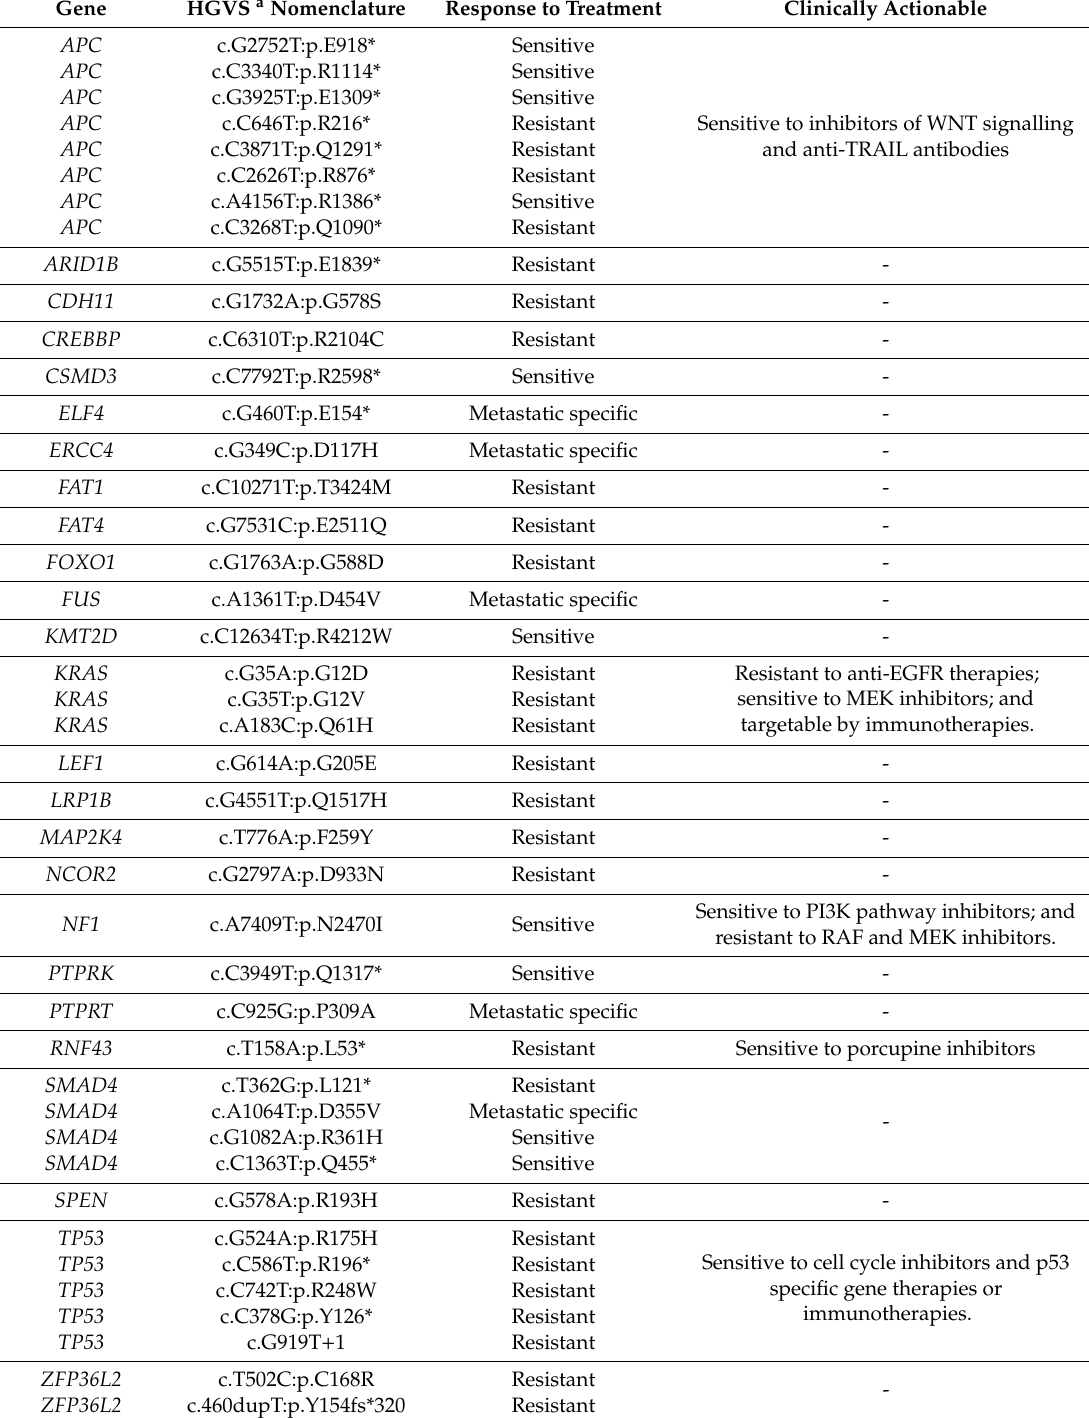
Table 2. Clinically relevant driver mutations implicated in colorectal cancer metastasis and therapy